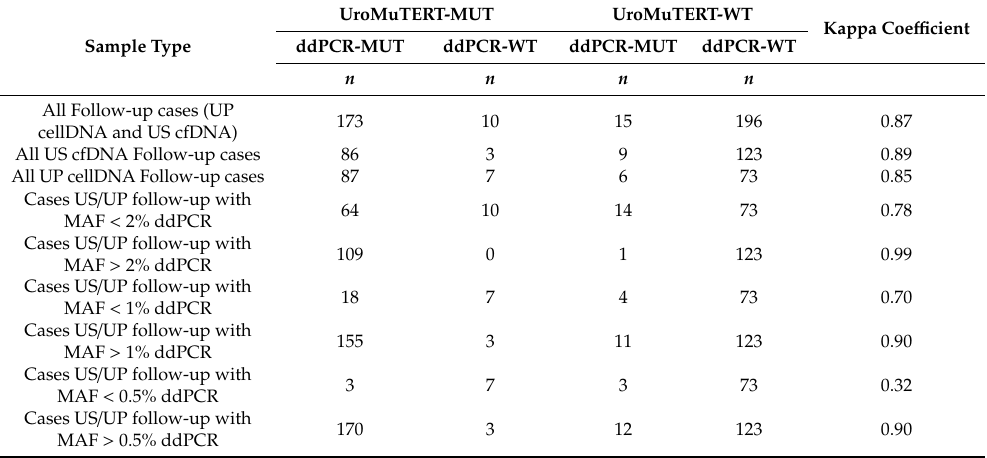
Table 2. Interrater reliability of ddPCR and UroMuTERT assays in detecting urinary TERT promoter mutations in a large series of serial urine samples from follow-up BC